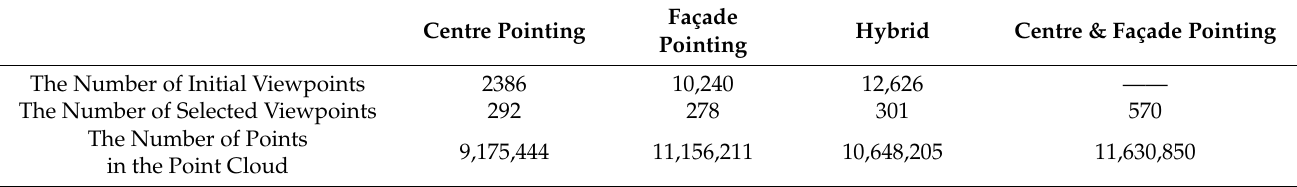
Table 3. The results of running the four approaches on the complex building. Façade Centre Pointing Hybrid Centre & Façade Pointing Pointing